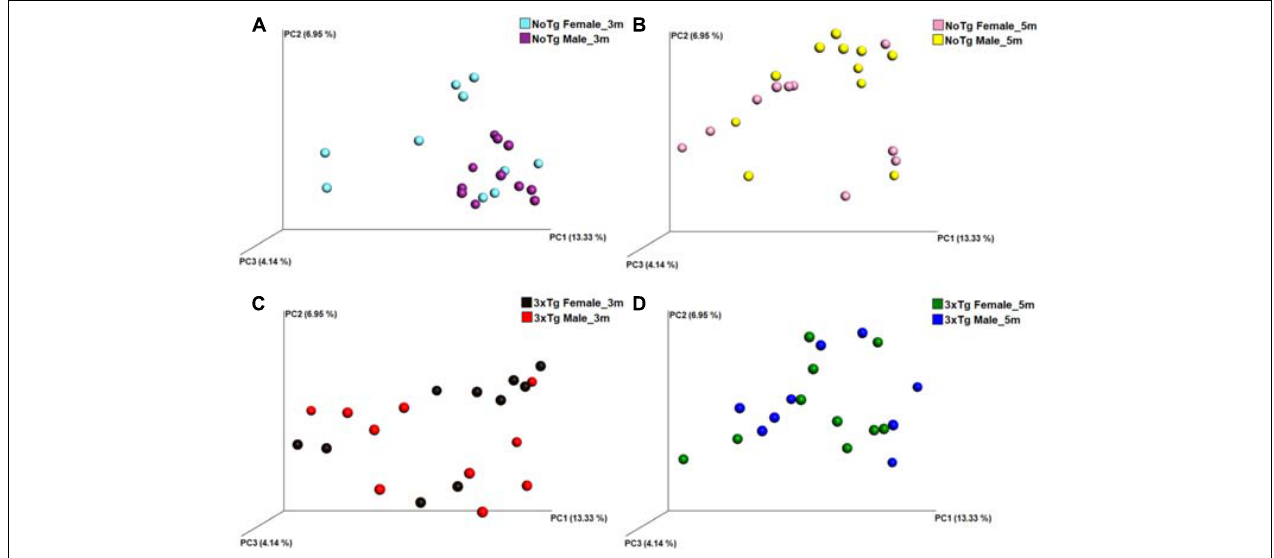
FIGURE 10 | Beta diversity of bacteria in fecal samples collected from non-transgenic (NoTg) and Alzheimer’s disease triple-transgenic (3xTg-AD) mice. The graphics show beta diversity analyses calculated by dissimilarity metrics using operational taxonomic unit (OTU) tables and Unweighted UniFrac analyses. The analyses show the dissimilarity among mice by colors: NoTg female at 3 months (m) old (cyan), 3xTg-AD female at 3 months old (black), NoTg female at 5 months old (pink), 3xTg-AD female at 5 months old (green), NoTg male at 3 months old (purple), 3xTg-AD male at 3 months old (red), NoTg male at 5 months old (yellow), 3xTg-AD male at 3 months old (blue). The data is comparing by sex NoTg and 3xTg; NoTg female and male mice at 3 months (A) , NoTg female and male mice at 5 months (B) , 3xTg female and male mice at 3 months (C) , and 3xTg female and male mice at 5 months (D) . The three-dimensional scatter plots were generated using principal coordinates analyses (PCoA) in three different axes which shows the percentage of total differences. There is significant difference on (A) according to ANOSIM similarity test ( R = 0 . 225, p = 0 . 002), but no for ( B , R = 0 . 082, p = 0 . 102), ( C , R = 0 . 037, p = 0 . 231), and ( D , R = 0 . 029, p = 0 .